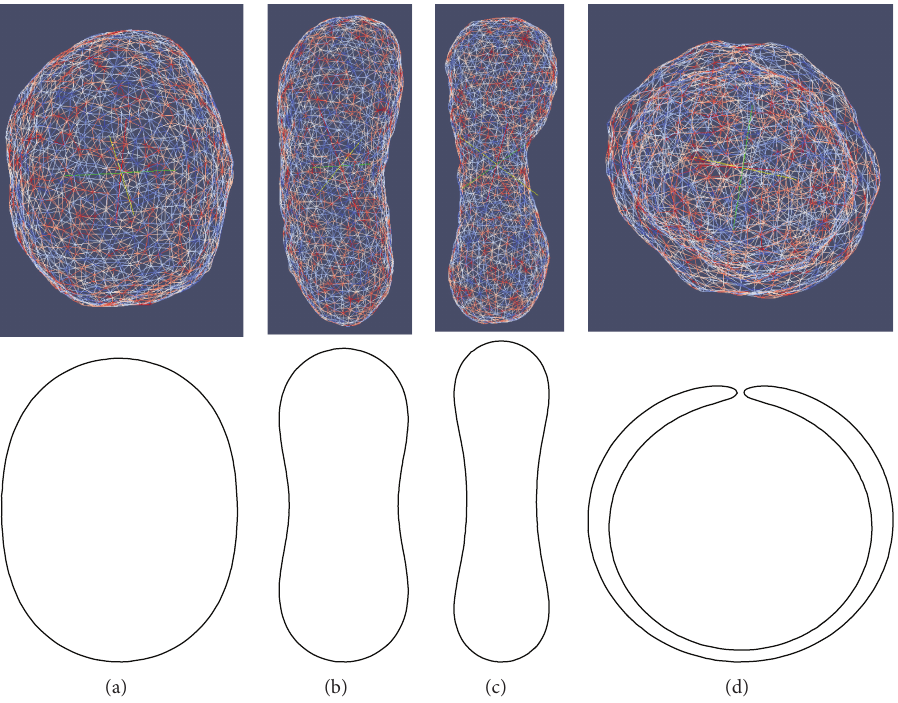
Figure 3: First row: snapshots of equilibrium configurations obtained by Monte Carlo simulations as described in Section 2.2. Second row: ground state shapes calculated with the minimization process as described in Section 2. Pressure differences are in units 𝑘 𝐵 𝑇/𝑙 3 min . All the shapes were calculated for 𝐶 0 = 0 . Parameters for first row pictures are as follows: (a) Δ𝑝 = −0.01 (with ⟨ V ⟩ = 0.949 ± 0.008 ), (b) Δ𝑝 = −0.05 (with ⟨ V ⟩ = 0.769 ± 0.003 ), (c) Δ𝑝 = −0.073 (with ⟨ V ⟩ = 0.66 ± 0.01 ), and (d) Δ𝑝 = −0.1 (with ⟨ V ⟩ = 0.172 ± 0.006 ). Shapes in the second row were calculated for the following reduced volumes: (a) V = 0.95 , (b) V = 0.77 , (c) V = 0.66 , and (d) V = 0.17 .